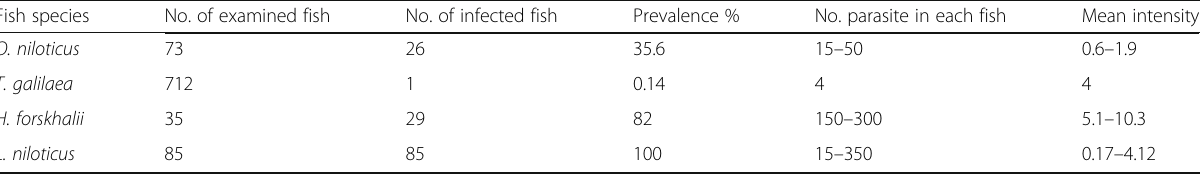
Table 2 The prevalence and mean intensity of Contracaecum larvae relative to fish species Fish species No. of examined fish No. of infected fish Prevalence % No. parasite in each fish Mean